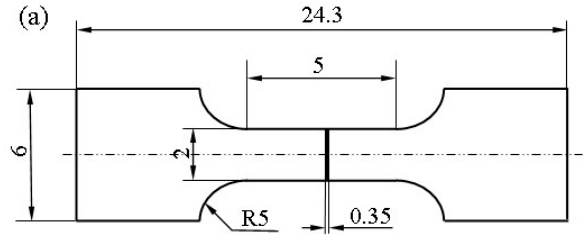
Table 1. The chemical composition of the 5140 alloy steel (wt.